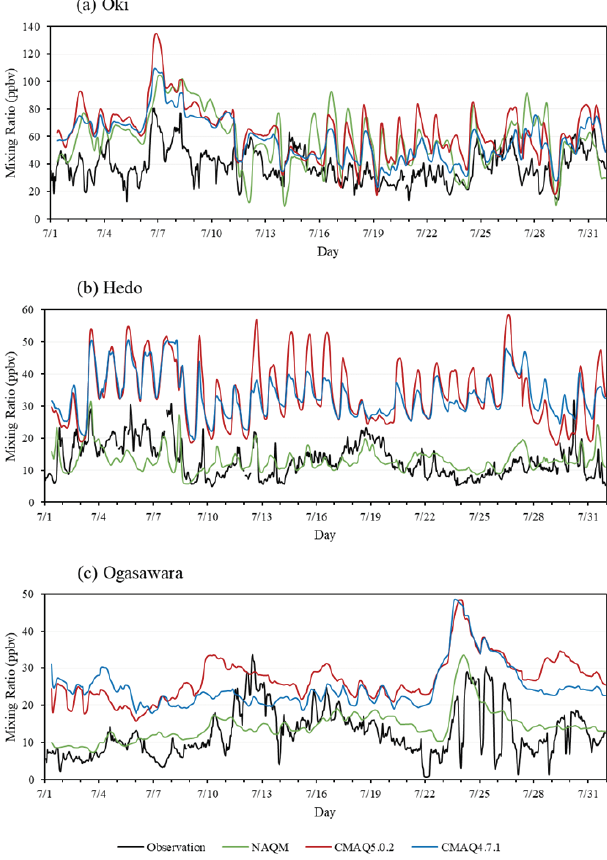
Figure 3. Comparison of diurnal variation of surface O 3 mixing ratios at (a) Oki, (b) Hedo, and (c) Ogasawara in July 2010 between observation and model simulation by CMAQ v.5.0.2 and v. 4.7.1 and NAQM v.3. Note that the vertical scale is different for Oki and